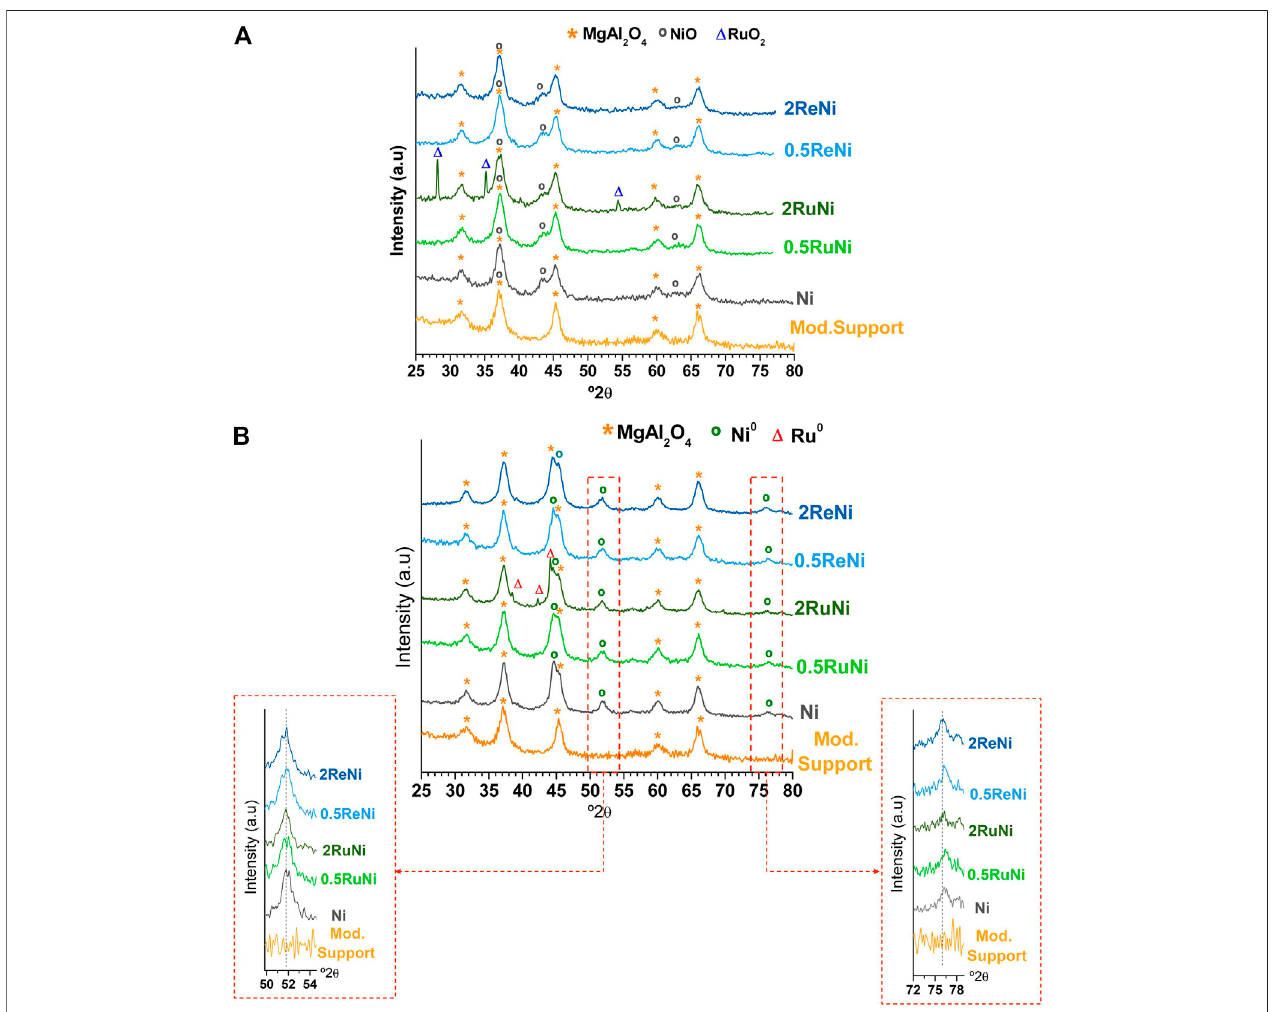
FIGURE 2 | XRD patterns: (A) calcined samples and (B) reduced samples.